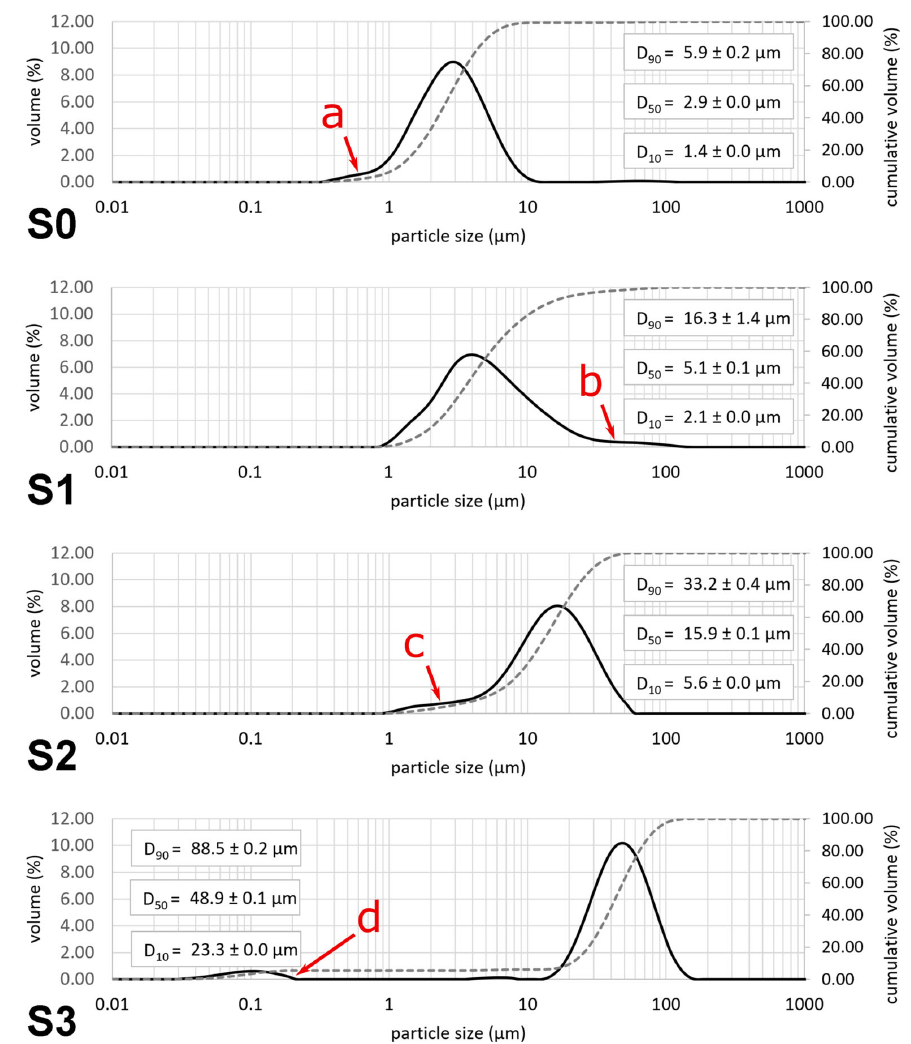
Figure 3. Particle size distributions of the suspensions S0 to S3 used in the coating process, particular sections of the curves highlighted by arrows and named.